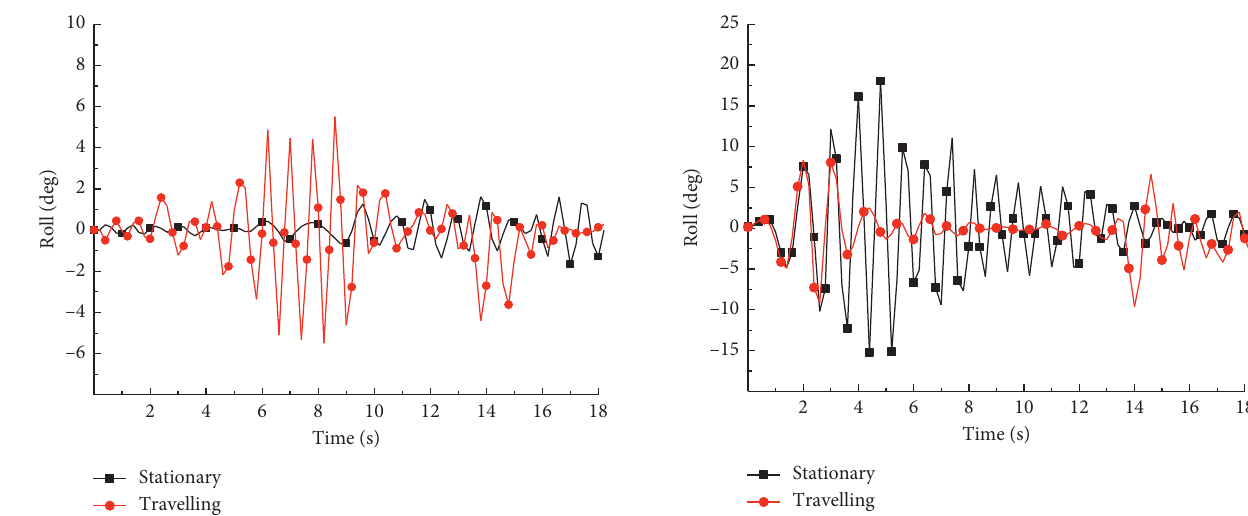
Figure 8: Time history curve of ship roll in straight section.